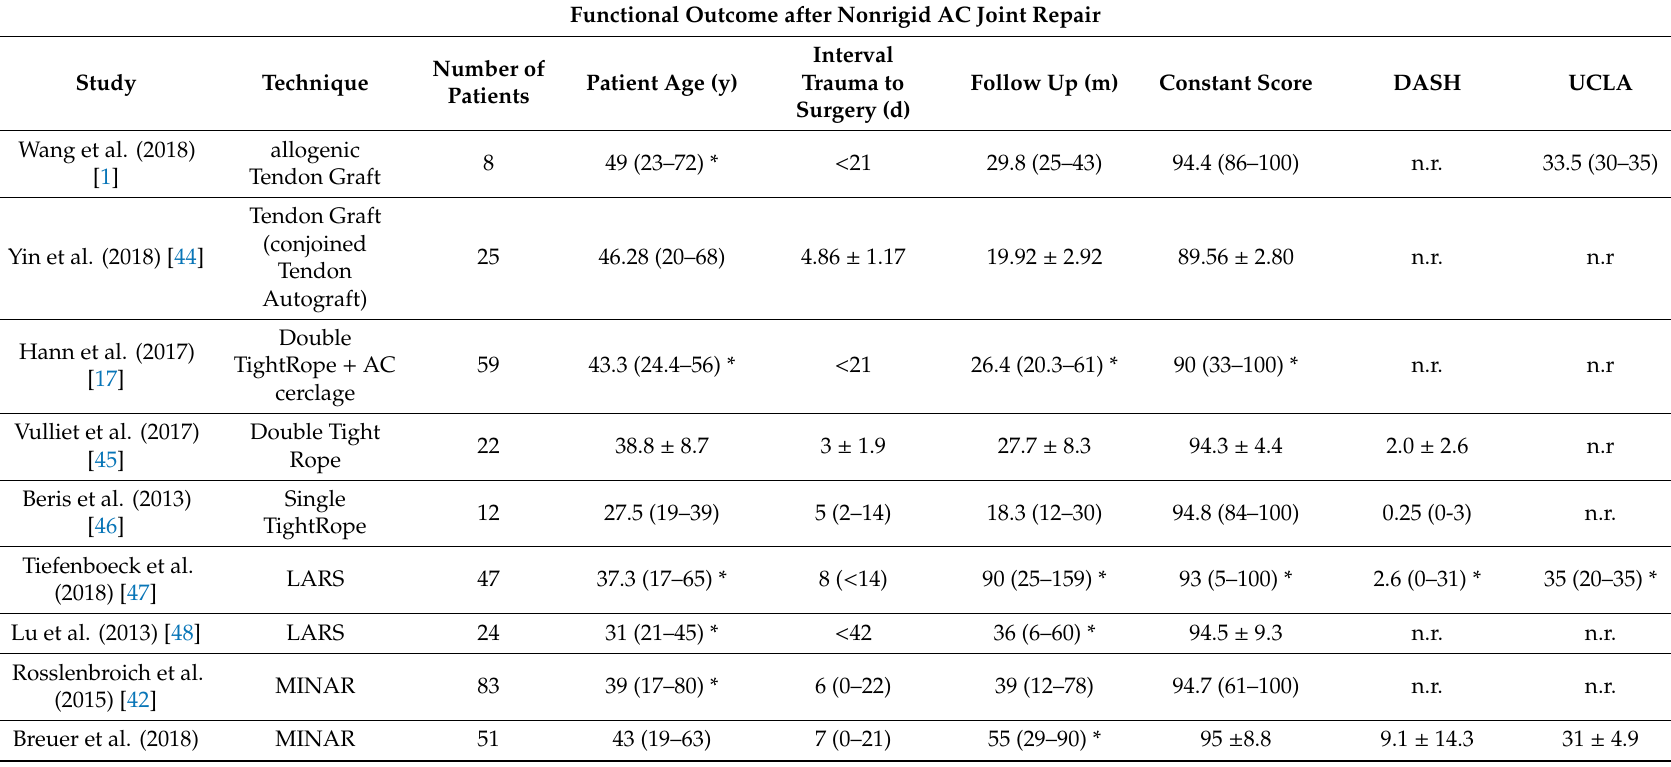
Table 4. Data is reported as mean ± standard deviation (range). N.r., data not raised; d, days; m,